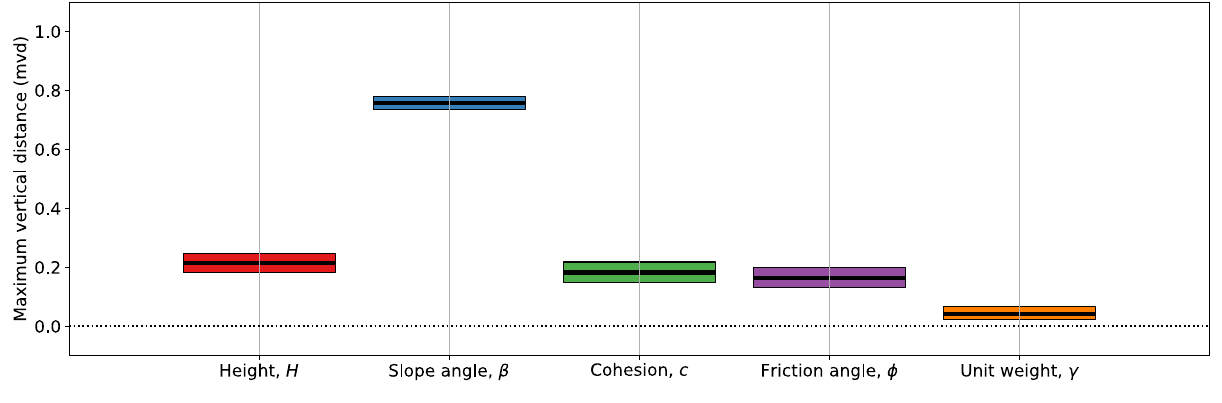
Figure 7. Boxplot of the sensitivity index for each variable. Table 2. Values of the sensitivity index and relative index of each variable.